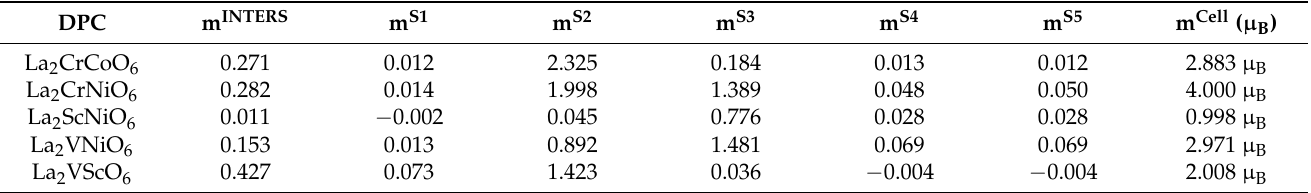
Table 2. Calculated spin magnetic moments of DPCs Using Generalised gradient approximation (GGA).